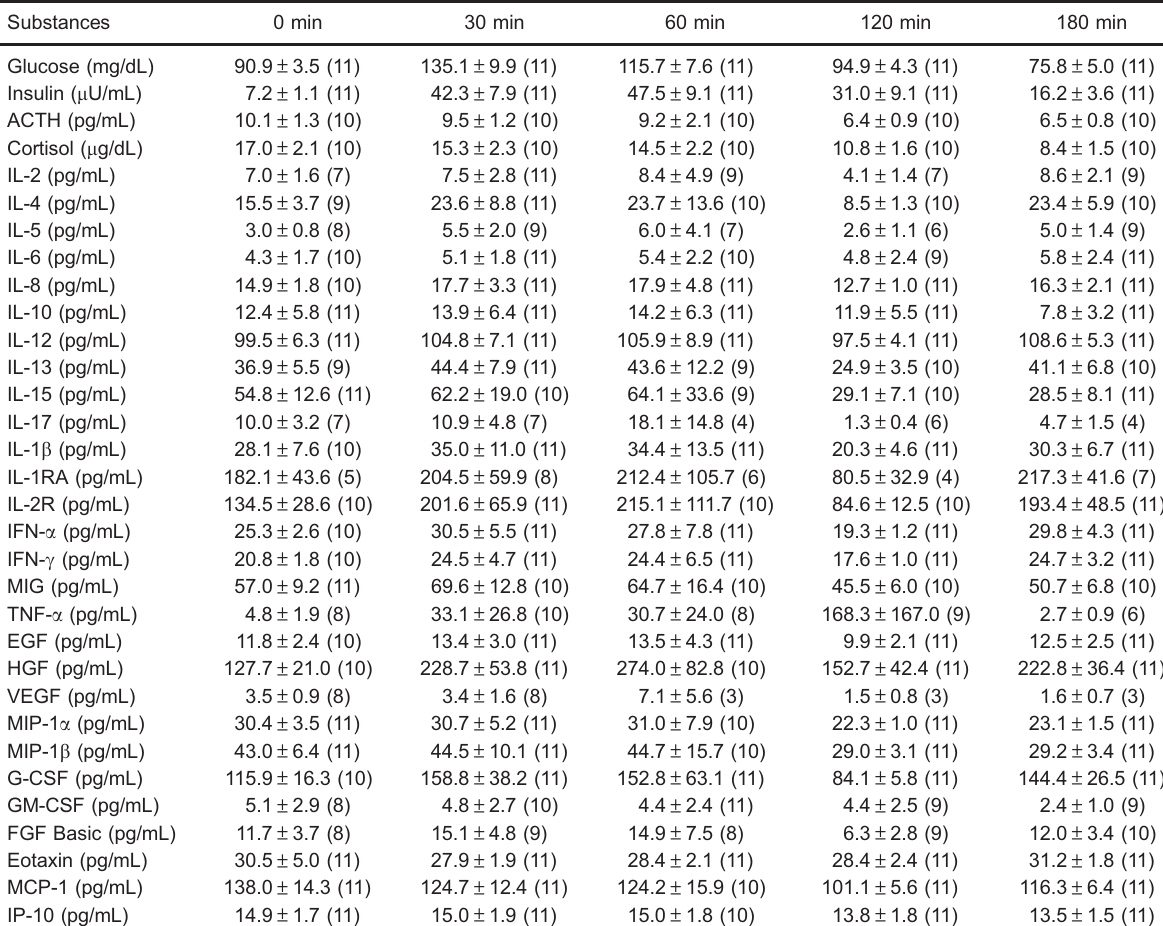
Table 2. Blood levels of evaluated parameters during 180 min after intake of a glucose solution (75 g).